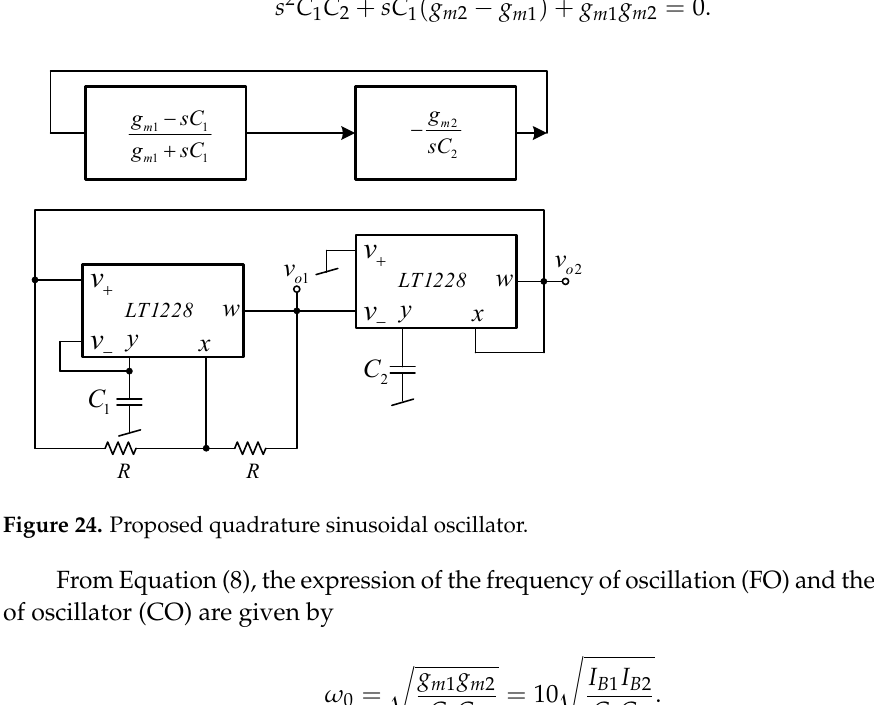
Figure 24. Proposed quadrature sinusoidal oscillator. To verify the functionality of the proposed quadrature oscillator in Figure 24, the experiment using the commercially available LT1228 IC was carried out. The supply volt ‐ age of ±5 V was applied with C 1 = C 2 = 2.2 nF, R = 1 k Ω , I B 1 = 132.58 μ A, and I B 2 = 137.41 μ A. The 470 Ω resistor was connected between the x and w terminal of second LT1228 to